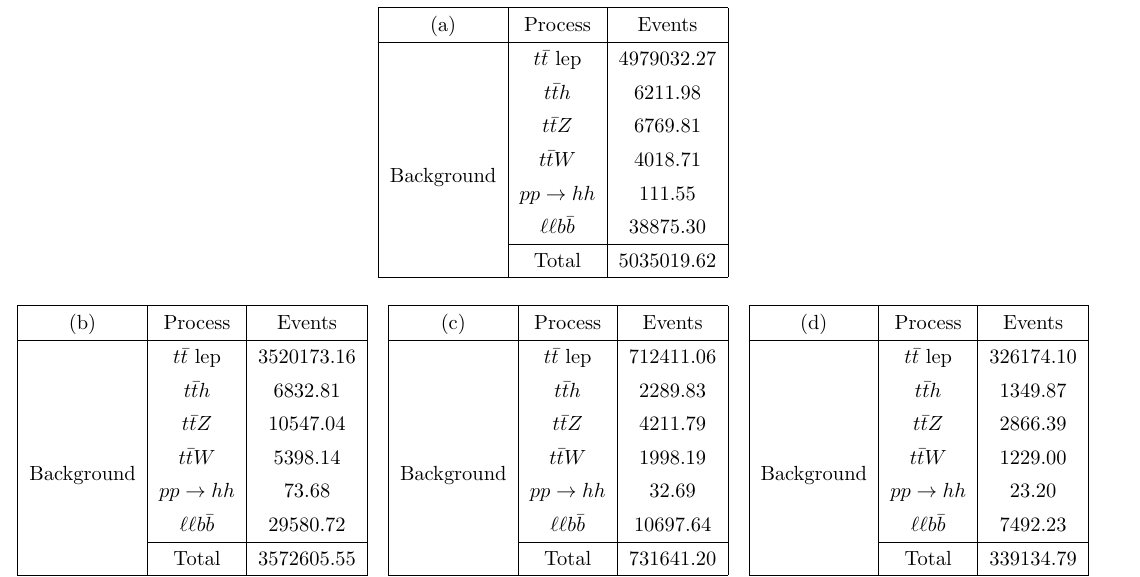
Table 15 . Respective background yields for the 2 ‘ + 2 b + = E optimised for m H = ( a ) 400 GeV, ( b ) 600 GeV, ( c ) 800 GeV and ( d ) 1 TeV. The various orders of the signal and backgrounds are same as in table